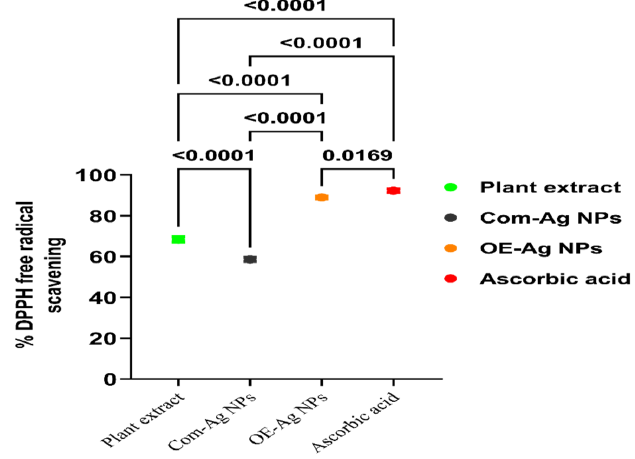
Figure 7. Antioxidant potential evolution in terms of percentage of DPPH free radical scavenging with green synthesized OE-Ag NPs compared to plant leaf extract, Com-Ag NPs, and standard antioxidant (ascorbic acid).